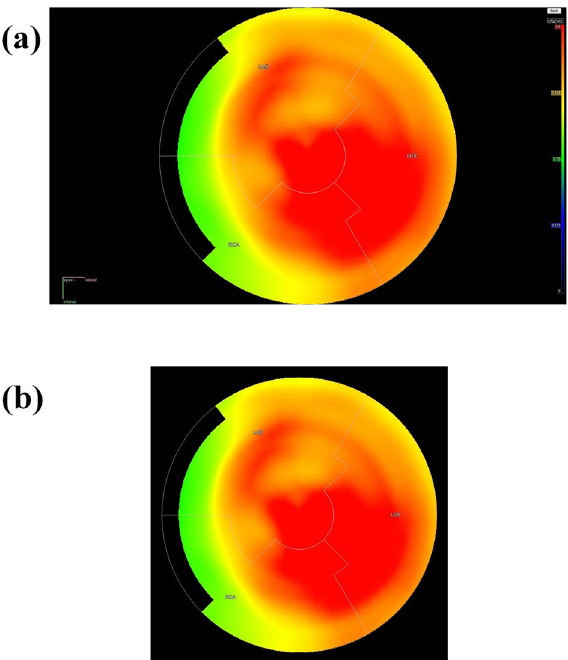
Figure 1. An example of an ( a ) original polar map JPEG image before cropping and resizing to smaller dimensions. After cropping and resizing, ( b ) only the polar map and the superimposed regional markings signifying LAD, LCX and RCA remain in a rectangular shape of 256 × 256 pixels. All polar maps were scaled between 0 and 3.5 ml/g/min before image export, where red and yellow color indicate normal stress MBF, whereas green and blue color indicate reduced stress